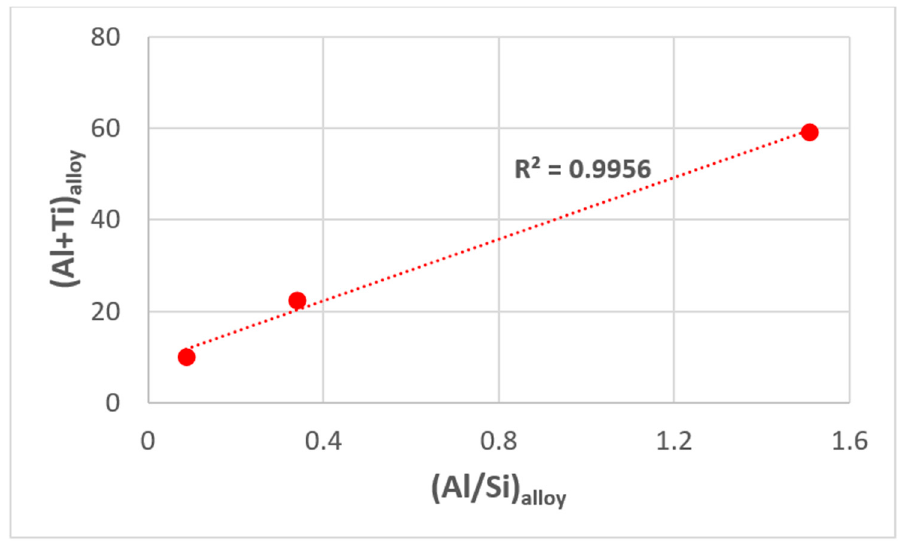
Figure 12. Plot of the relationship between (Al + Ti) alloy versus (Al/Si) alloy for the alloys OHC2, OHC5, and MG7 that form Zone A and/or layered microstructures [21,29,30], see text.